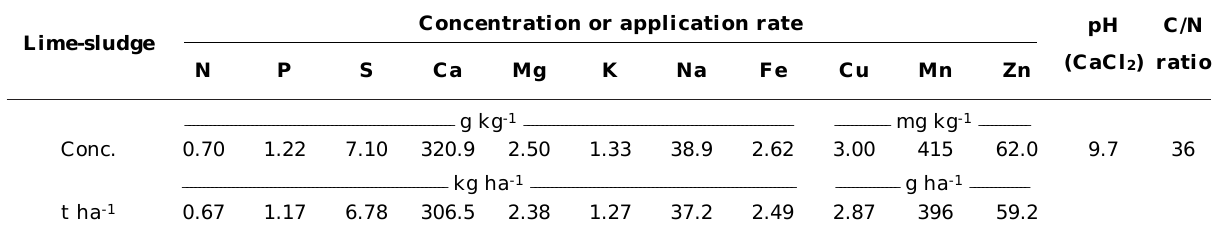
Table 2. Chemical characteristics, C/N ratio, and application rate of the lime-sludge